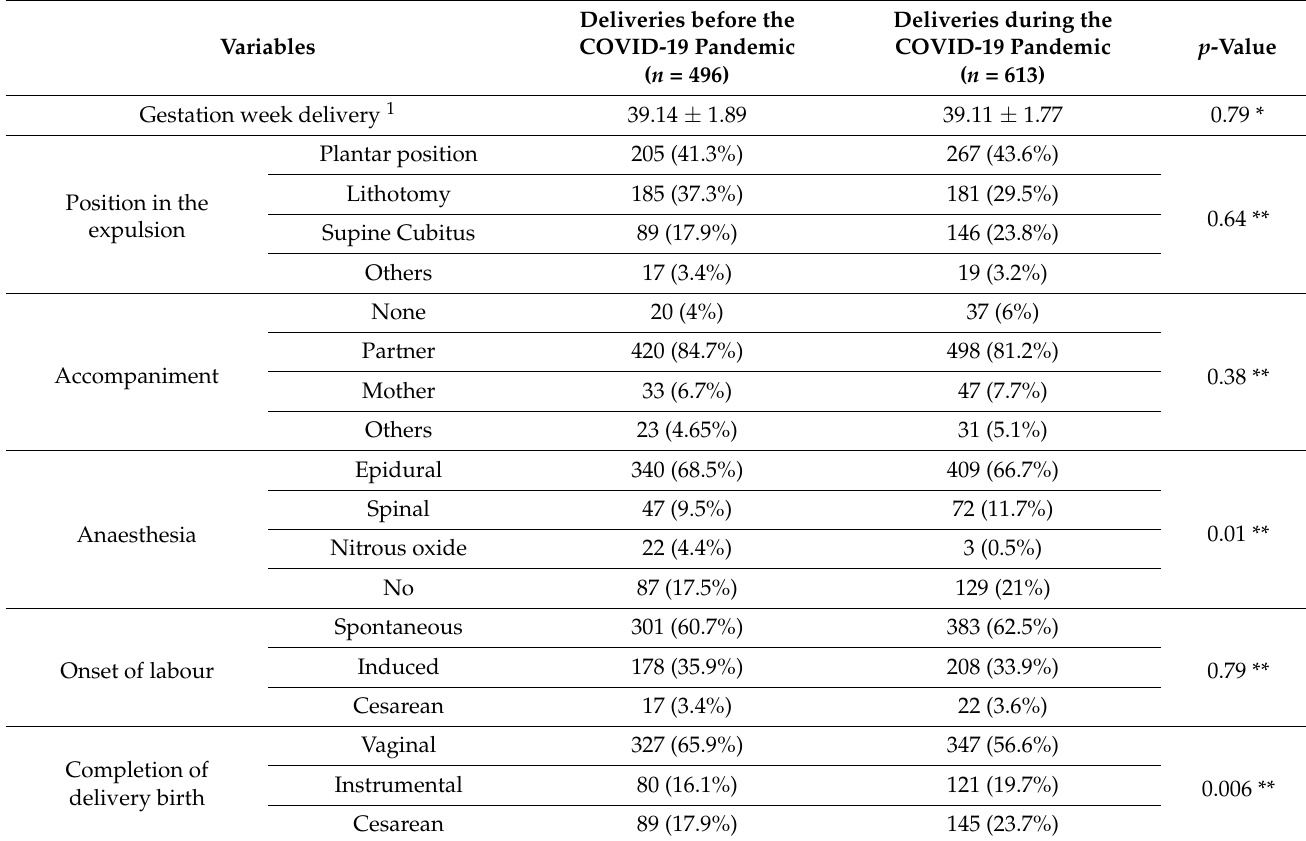
Table 2. Comparison of the data on the labour process between the two groups, “before the COVID-19 pandemic” and “during the COVID-19